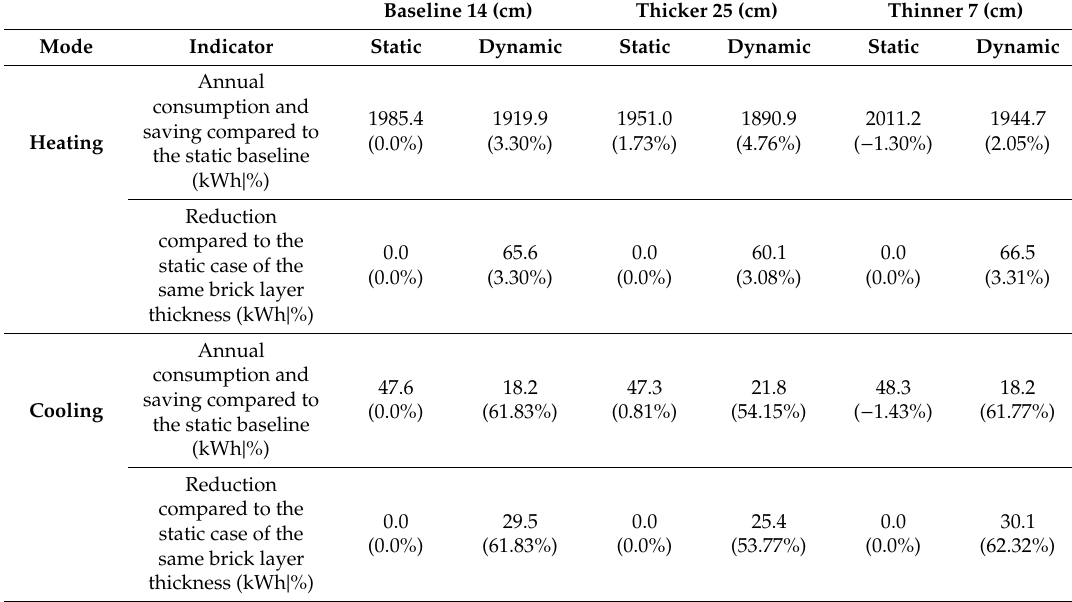
Table 5. Comparison of annual space heating and cooling energy consumption for various thicknesses of the interior brick layer for static and dynamic insulated walls of the prototypical Belgian apartment